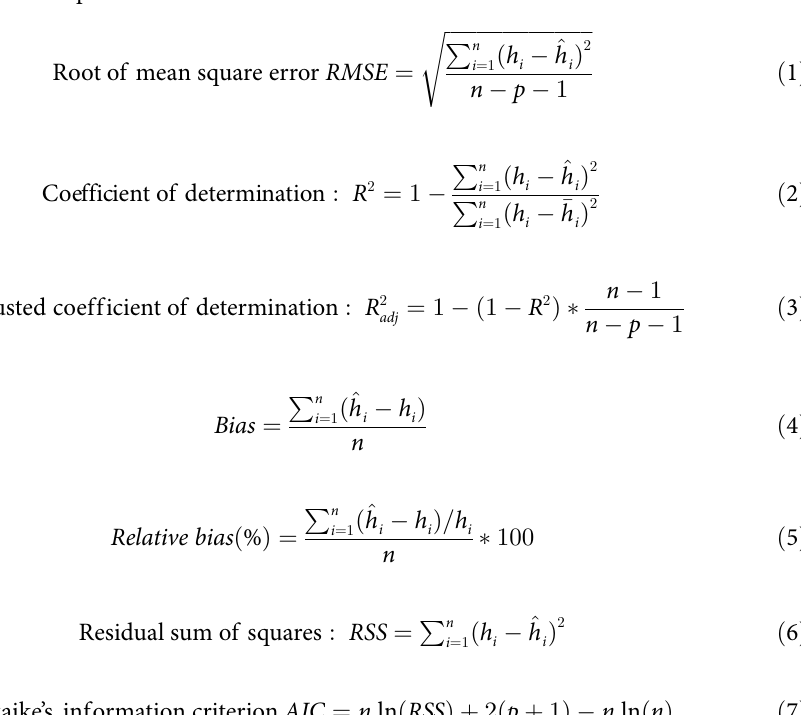
ffiffiffiffiffiffiffiffiffiffiffiffiffiffiffiffiffiffiffiffiffiffiffiffiffiffiffiffiffi P n